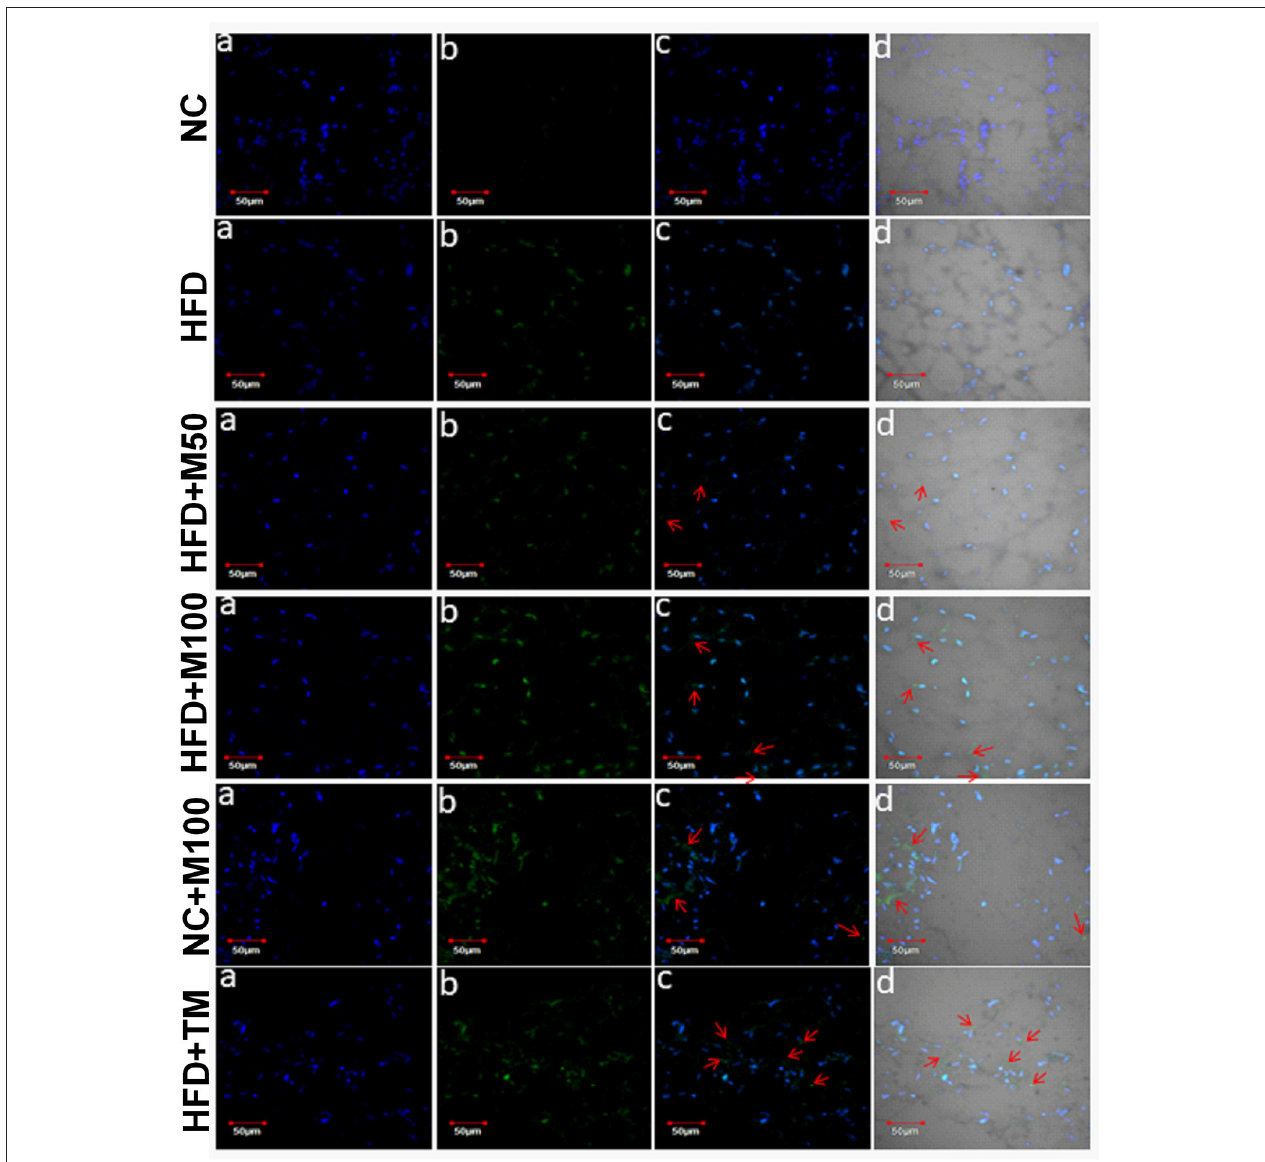
FIGURE 6 | Representative images of UCP1 immunohistochemistry in adipose tissue of chronic oral and topical menthol treated HFD fed mice. (a) Nucleus is stained blue by DAPI; (b) UCP1 is stained green by FITC; (c) FITC and DAPI merged images; and (d) Merged image of DAPI, FITC with their corresponding differential interface contrast images. Arrowheads indicate immunopositive cells. NC, normal rodent chow fed; HFD, high fat diet fed; HFD + M50, HFD fed plus daily administration of 50 mg/kg menthol ( p.o. ); HFD + M100, HFD fed plus daily administration of 100 mg/kg menthol ( p.o. ); NC + M100, NC fed plus daily administration of 100 mg/kg menthol ( p.o. ); HFD + TM, HFD fed plus daily application of 10% topical